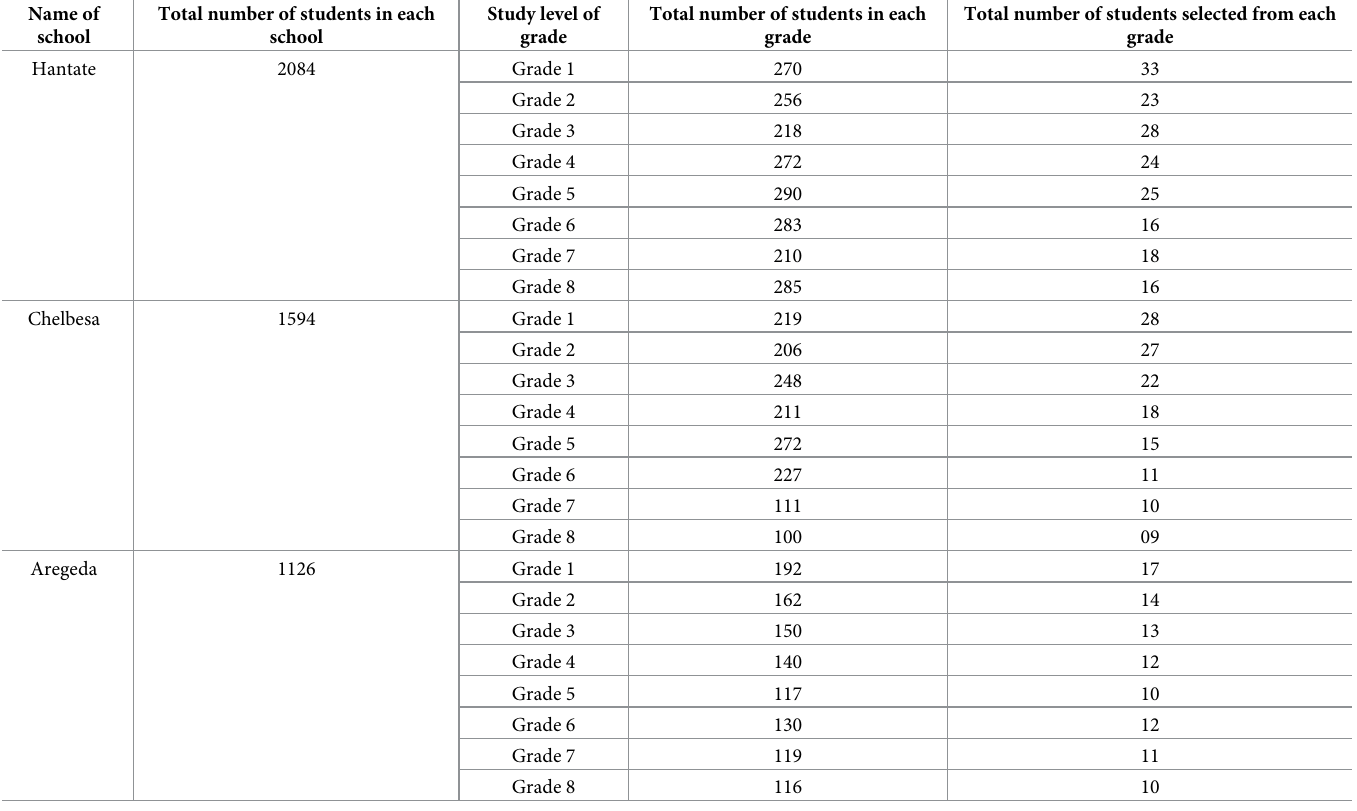
Table 1. Selection of number of participants in each school from grade level 1 to 8 by proportion allocation method. Name of Total number of students in each school school